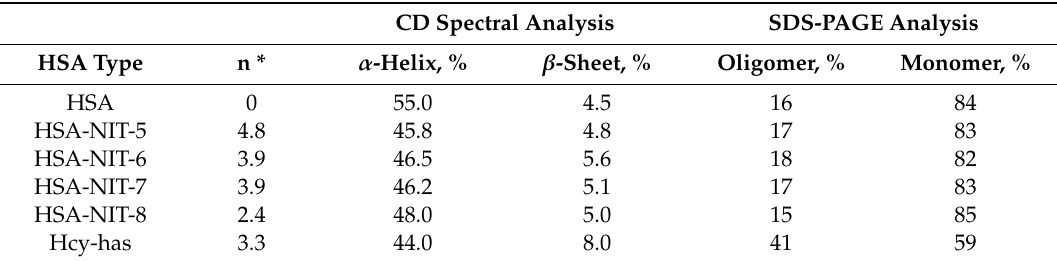
HSA conjugate secondary structure from CD and aggregates from quantitative SDS–PAGE